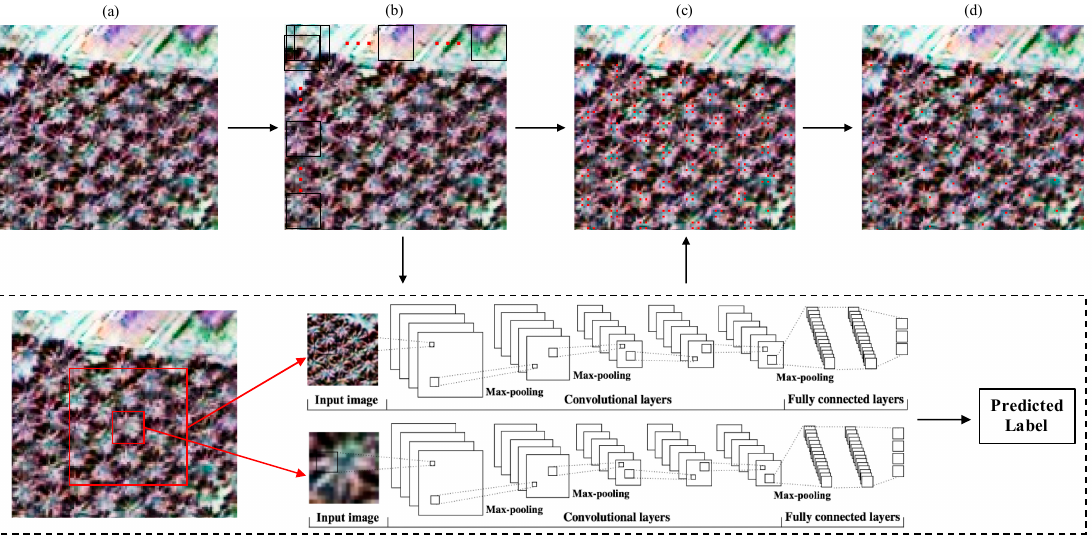
Figure 5. Multi-scale sliding-window-based image dataset collection and label prediction.